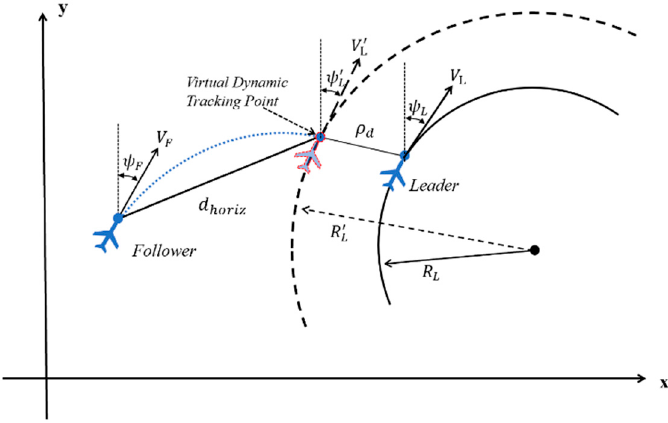
Figure 1. Lateral movement of the leader-follower formation.